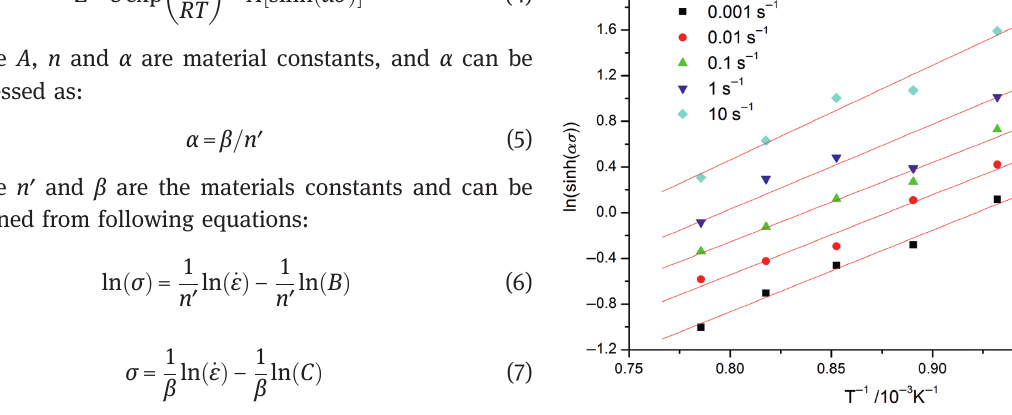
Figure 6: Relationship between ln[sinh( ασ )] and 1/